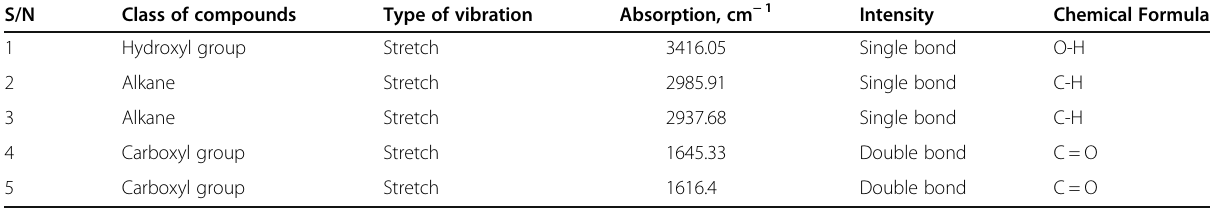
Table 3 Characteristic FTIR absorption frequency of organic functional group in crude ethanol extract of Cassava peel biogas slurry S/N Class of compounds Type of